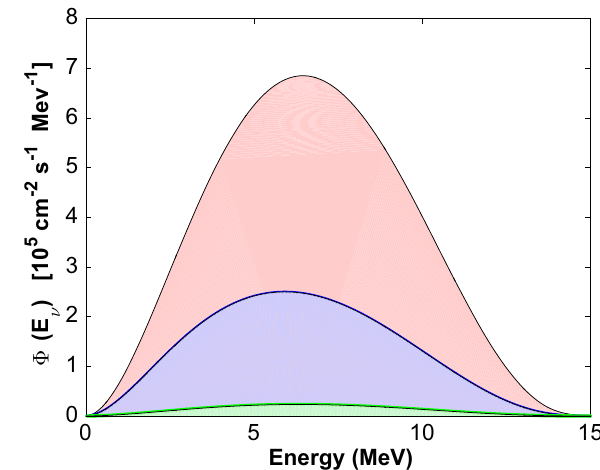
Fig. 5 Neutrino spectrum of pp nuclear reaction: the Φ t ( E ) (red area) is the electron neutrino spectrum inside the Sun. Φ (cid:10) ee ( E ) (blue area) and Φ (cid:10) ( E ) (green area) are the survival electron and sterile solar neutrino es spectra for the PP neutrinos 3 + 1 neutrino flavour oscillation model